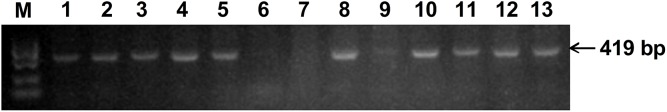
The PCR detection of transgenic offspring.M, marker, 1–13 represents transgenic offspring.